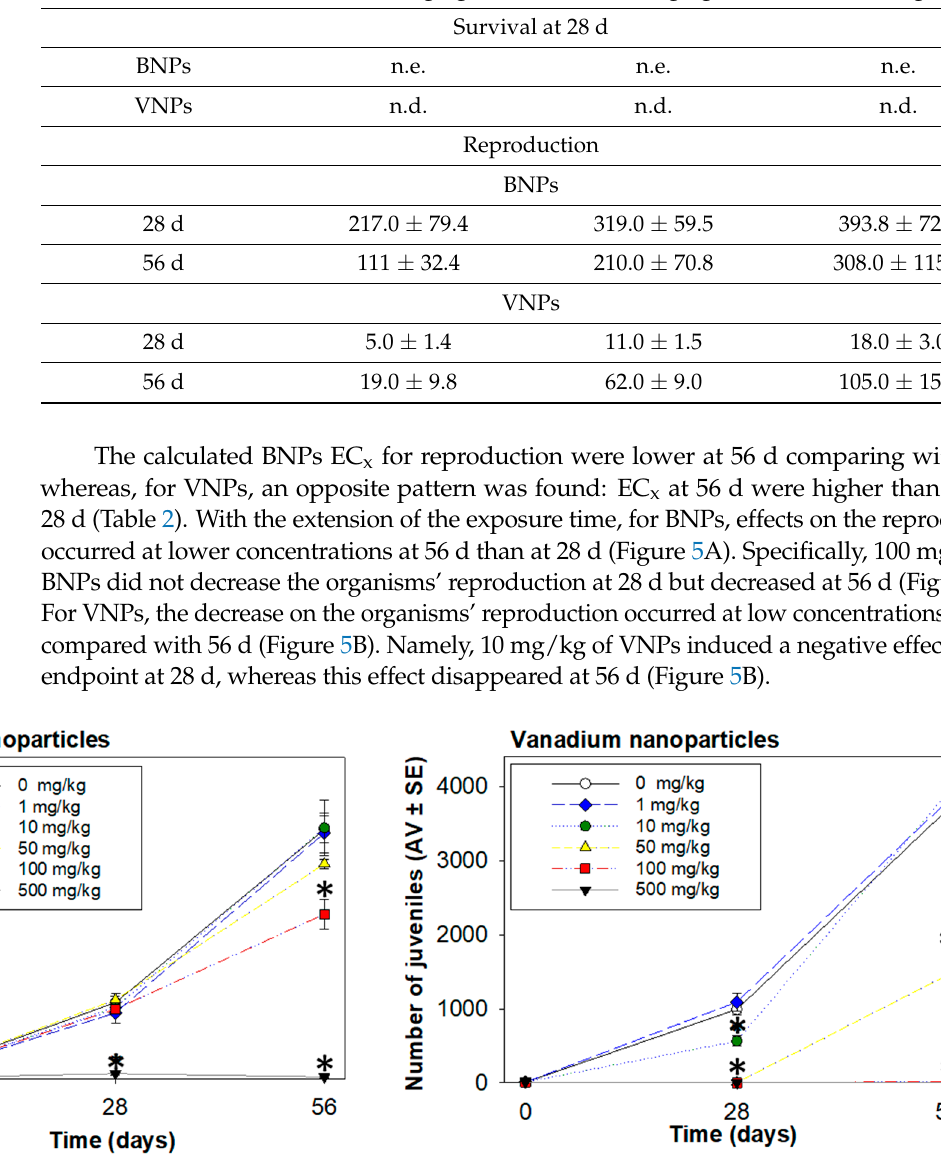
Table 2. Effect Concentrations (EC x ), applying the 2-parameters Logistic model, for Enchytraeus crypticus survival, assessed at 28 days, and reproduction, assessed at 28 and 56 days, after exposure to boron nanoparticles (BNPs) and vanadium nanoparticles (VNPs) in LUFA 2.2 soil. EC 20 , 50 and 80 : Concentration that causes 20%, 50%, and 80% of the effect, respectively. n.e.—no effect; n.d.—not possible to determine. Results are presented as estimated value ± standard error.